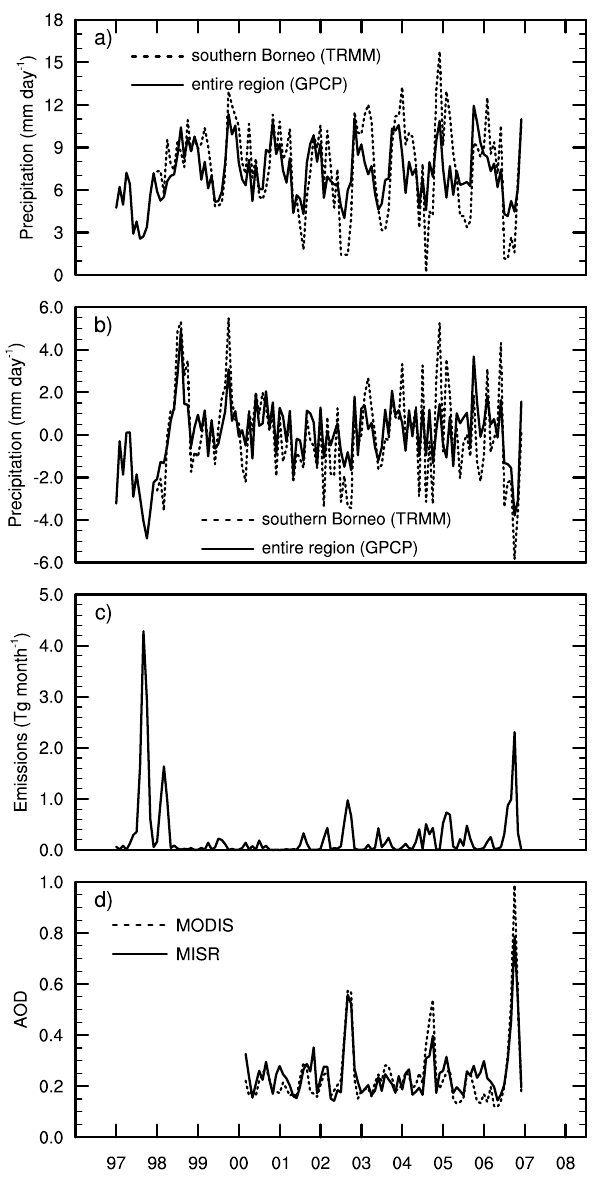
Fig. 1. Satellite-derived observations of precipitation, fire emis- sions and aerosol optical depth for equatorial Asia (90 ◦ E–120 ◦ , 5 ◦ S–5 ◦ N) during 1997–2006. (a) Monthly mean precipitation to- tals from GPCP (mmday − 1 ) for the entire region (solid line) and for southern Borneo from TRMM (south of 1 ◦ S; dashed line). (b) Precipitation anomalies (mm day − 1 ) – similar to (a) but with the annual mean cycle of monthly precipitation removed from both the GPCP and TRMM time series. (c) The sum of BC and OC aerosols from GFEDv2 (Tg month − 1 ). (d) Aerosol optical depths are from both MISR (solid line) and MODIS (dashed